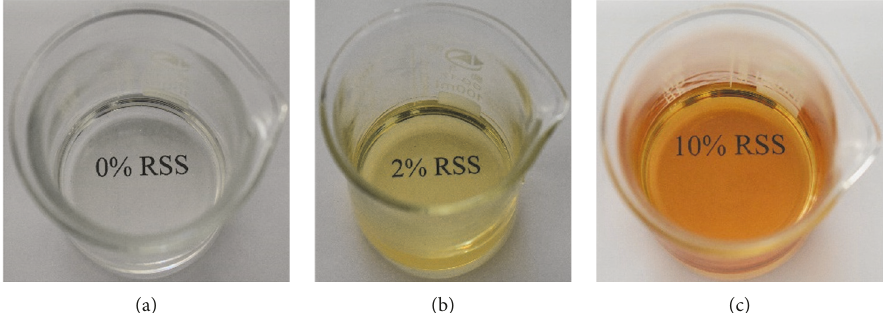
Figure 2: Mixed solutions with different mass ratios: (a) ER :CA :RSS � 1 :1: 0; (b) ER: CA: RSS � 25: 25:1; (c) ER:CA : RSS � 5:5 :1.